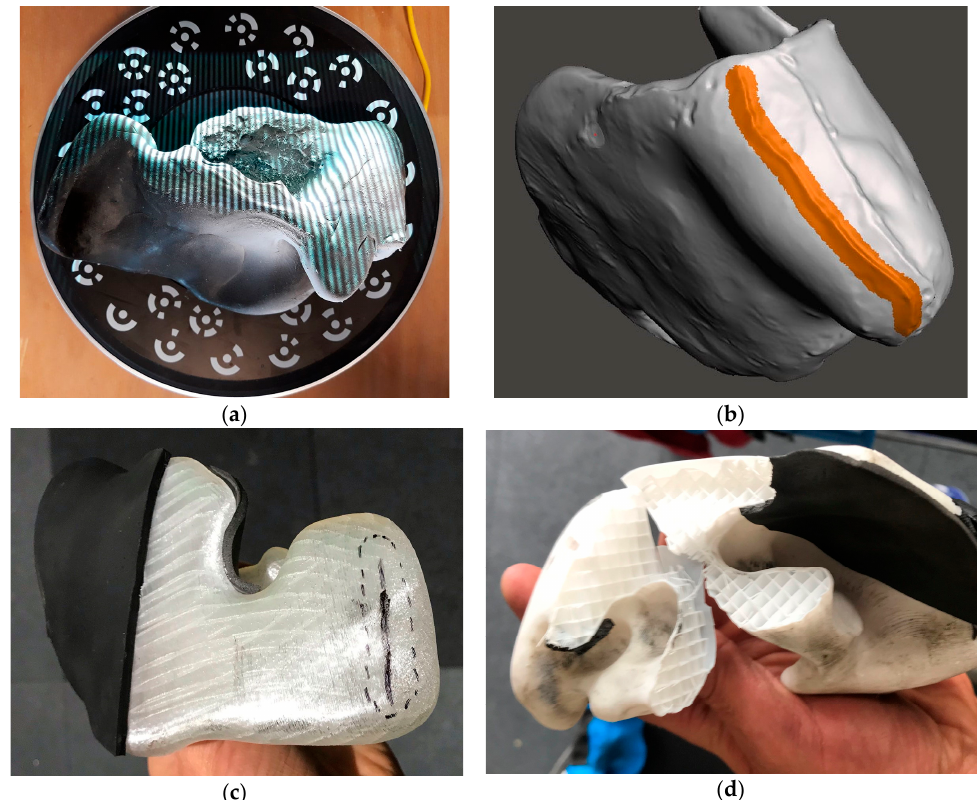
Figure 4. Initial glove forms made: ( a ) using a thermoformable polymer (Polymorph PCL thermoplastic, Mindsets) was 3D scanned using a Shining EinScan-SP Desktop 3D scanner; ( b ) digital smoothing was achieved using Meshmixer (Autodesk); ( c ) 3D printed glove samples were initially produced initially using Premium PLA (Raise3D) on a N2 Plus machine (Raise3D) then lined with a rubber compound to provide traction; ( d ) after some field testing on a treadmill and on the road, the lightest prototype (20% infill) failed by delaminating between layers in the transition area between the grip and the contact area.